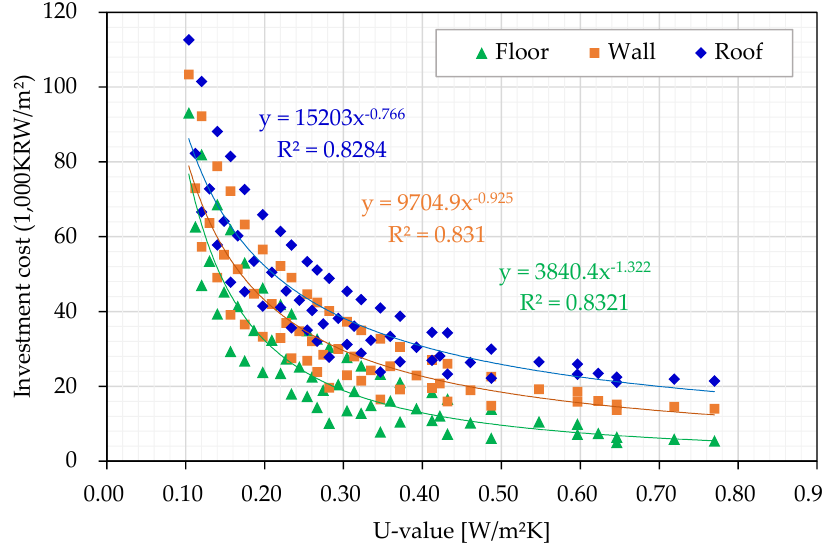
Figure 1. Relationships between the U-value and investment cost of the building envelope.